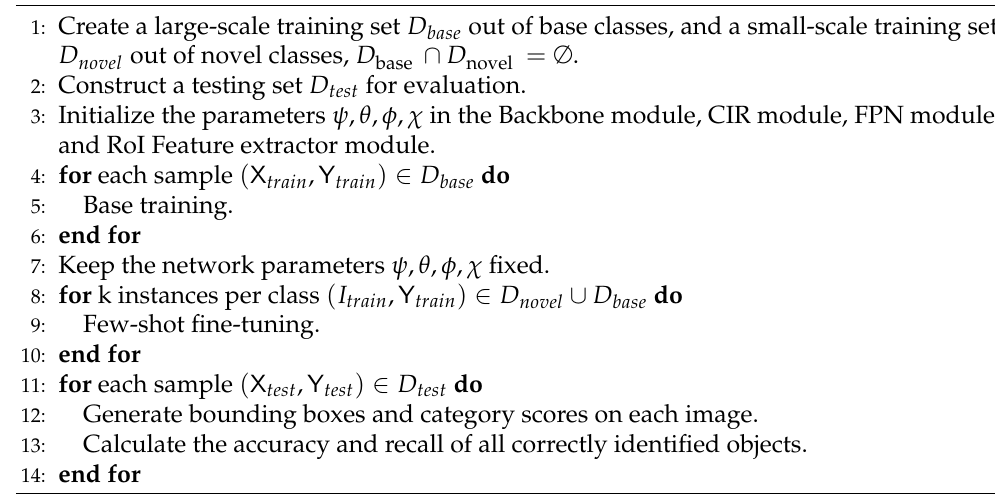
Algorithm 1 Process of Training and Testing for the